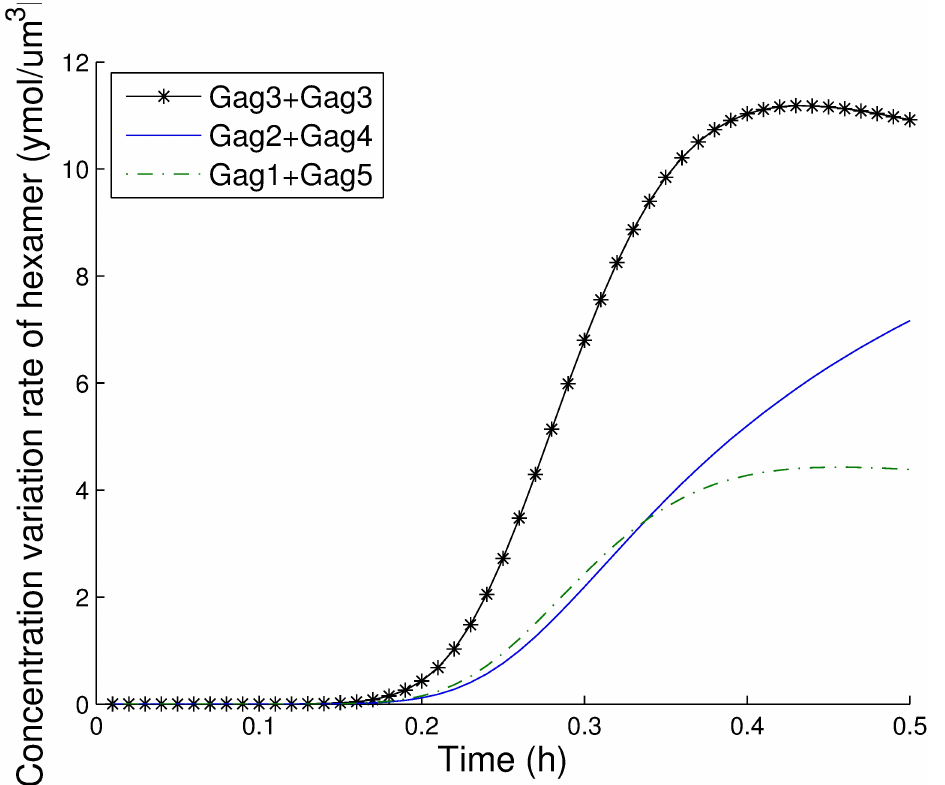
Fig 10. The contributions of three pathways to form